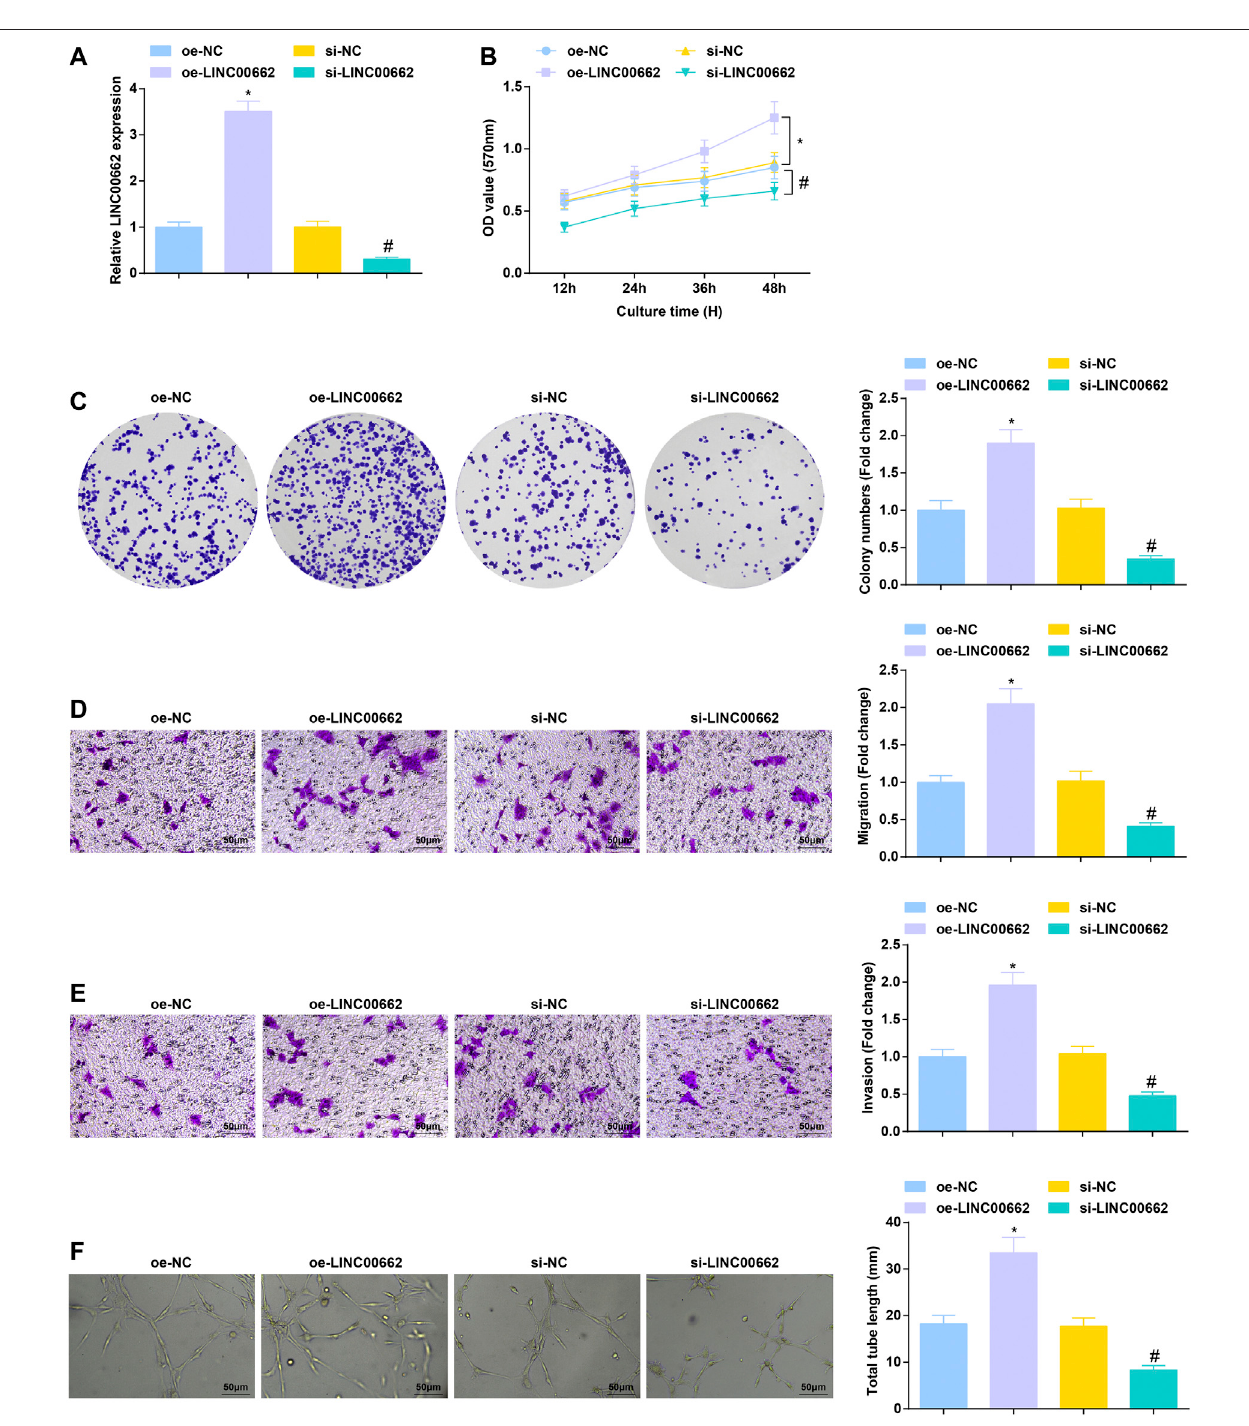
FIGURE 2 | Repressive role of LINC00662 downregulation in angiogenesis. (A) RT-qPCR detection of LINC00662 expression in HUVECs after transfection with silenced LINC00662; (B,C) Viability and colony formation ability of HUVECs after transfection with silenced LINC00662; (D,E) Migration and invasion of HUVECs after transfection withsilenced LINC00662; (F) Angiogenesis ofHUVECs aftertransfectionwithsilenced LINC00662. * p < 0.05vs. theoe-NCgroup;# p < 0.05vs. thesi-NC group.